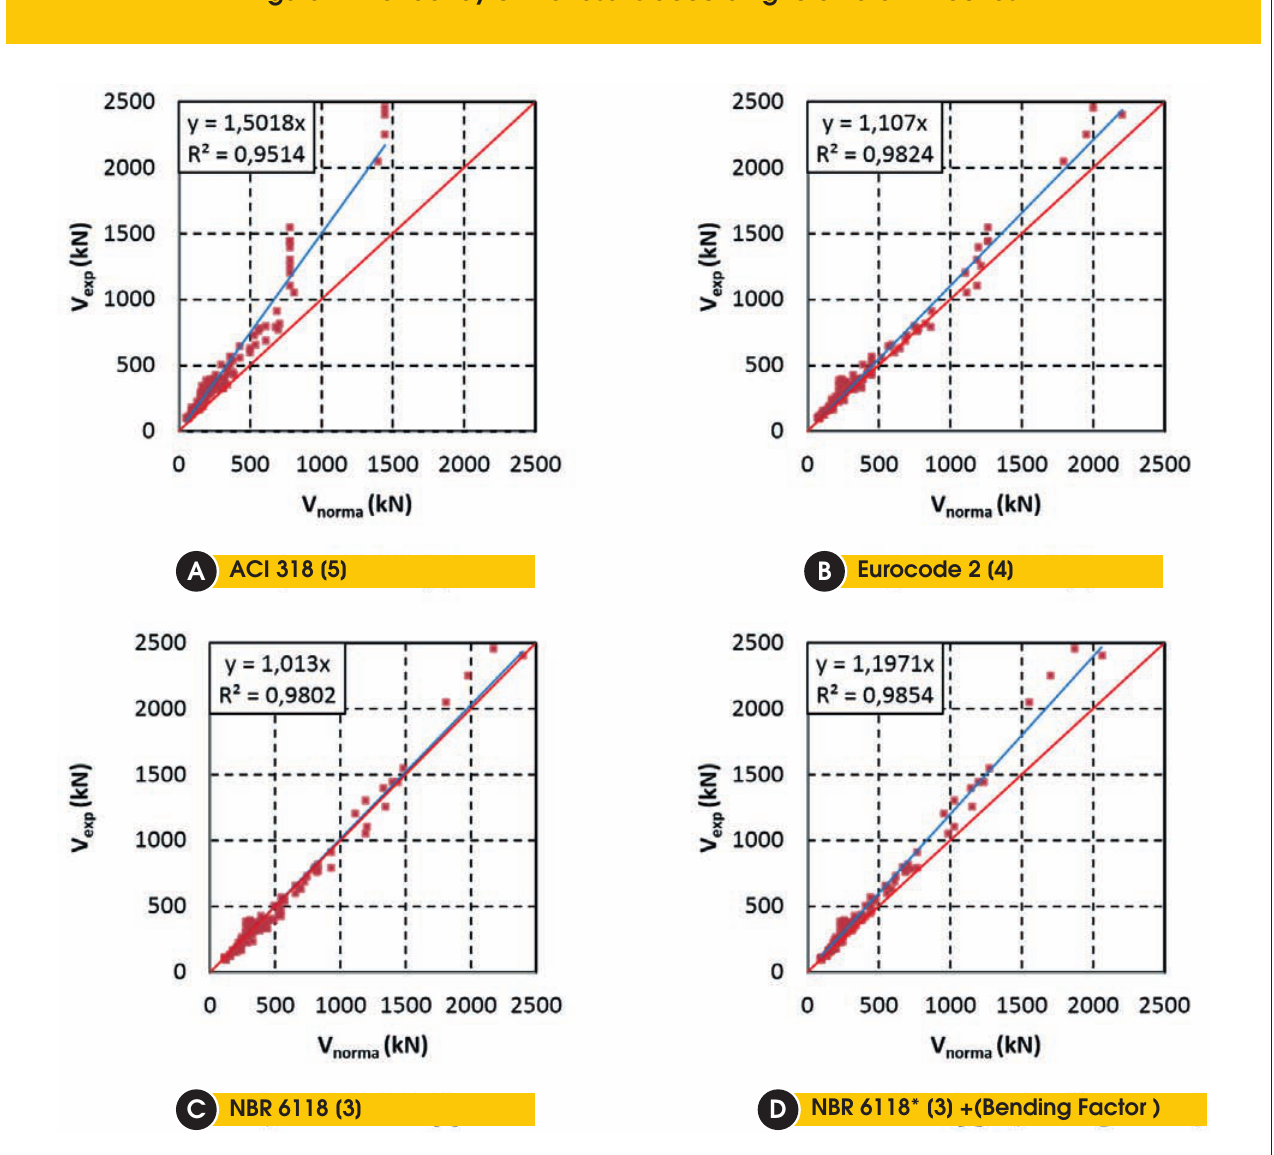
Figure 7 – Tendency of the results according to different